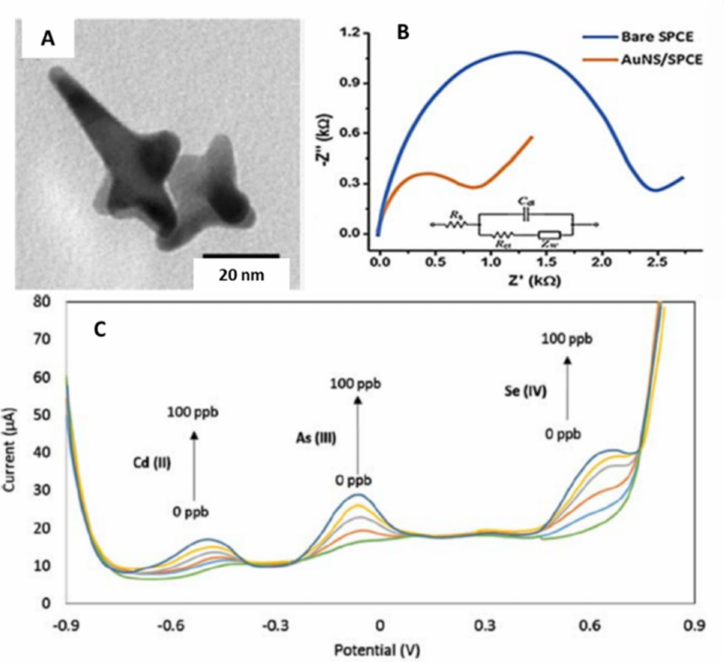
Figure 6. ( A ) TEM micrograph of gold nanostars. ( B ) Nyquist plot of the bare and gold nanostar mod- ified screen-printed electrode in the presence of the redox probe 10 mM Fe(CN) 63 − /4 − . ( C ) SWASV curves of the AuNS-modified SPCE for the simultaneous detection of Cd(II), As(III), Se(IV) in a concentration range of 0 to 100 µ g L − 1 . Reproduced with permission of Lu et al., Analytical and Bioanalytical Chemistry; published by Springer, 2020 [43].